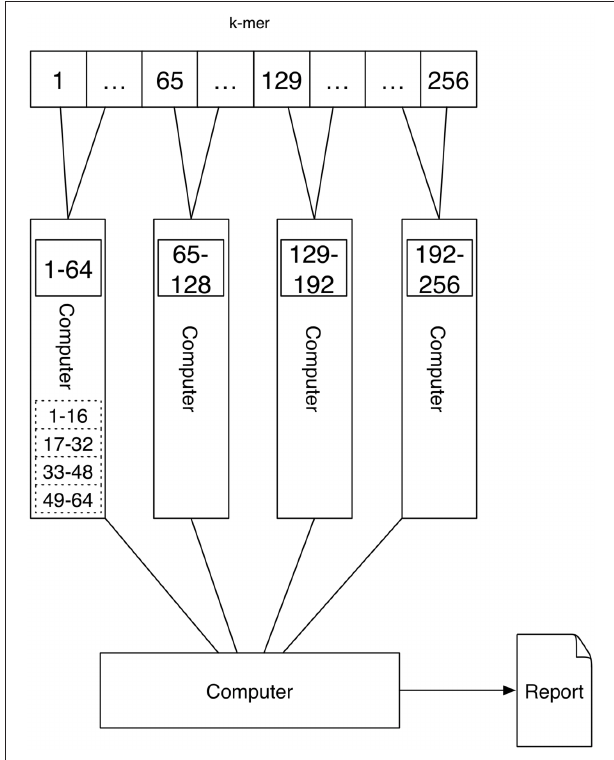
FIGURE 5 | Job scheduling cluster computing: The setup of Job scheduling cluster computing is similar to that of Message Passing. There are four computers with a single or multiple processors that execute the task of counting the k -mers. However, there is no communication between the computers. Therefore, each computer stores its results to hard disk. After all computers have finished the k -mer counting the results have to be read from hard drive and are gathered to be able to output the